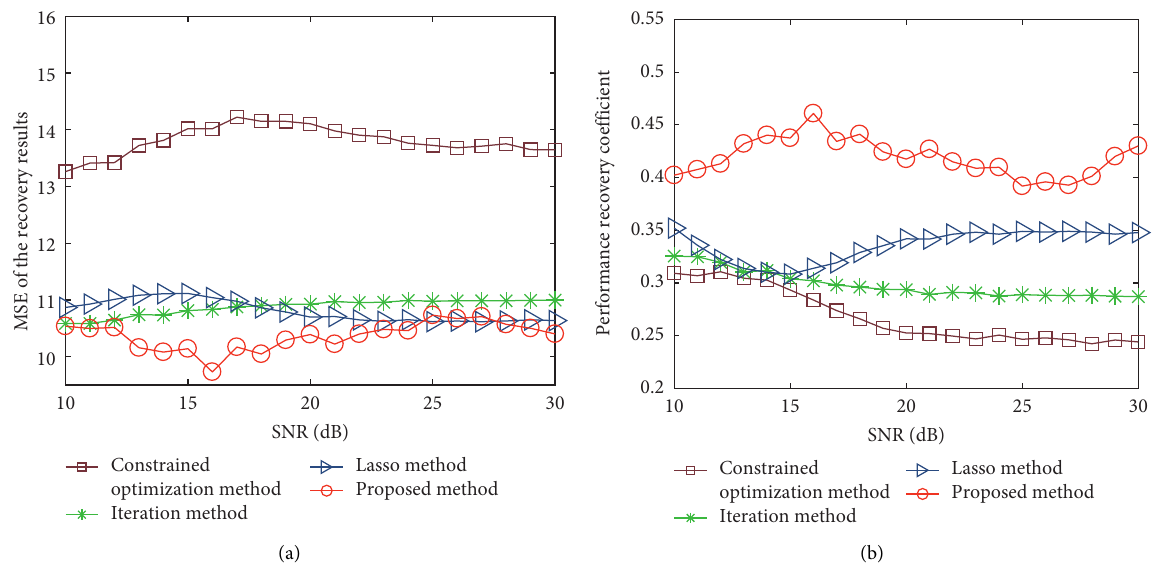
Figure 6: MSE and PRC of the sparse recovery results with the constrained optimization method [14], iterative method [15], Lasso method, and proposed method with different SNRs ( M � N � 15, c � 15, and ρ � 0 . 2). (a) MSE of the sparse recovery results with different SNRs. (b) PRC of the sparse recovery results with different